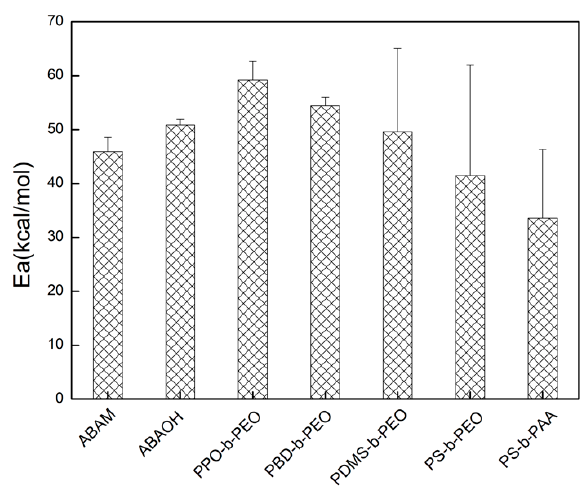
Figure 4. Arrhenius activation energy for osmotic transport of water across various polymeric vesicles.